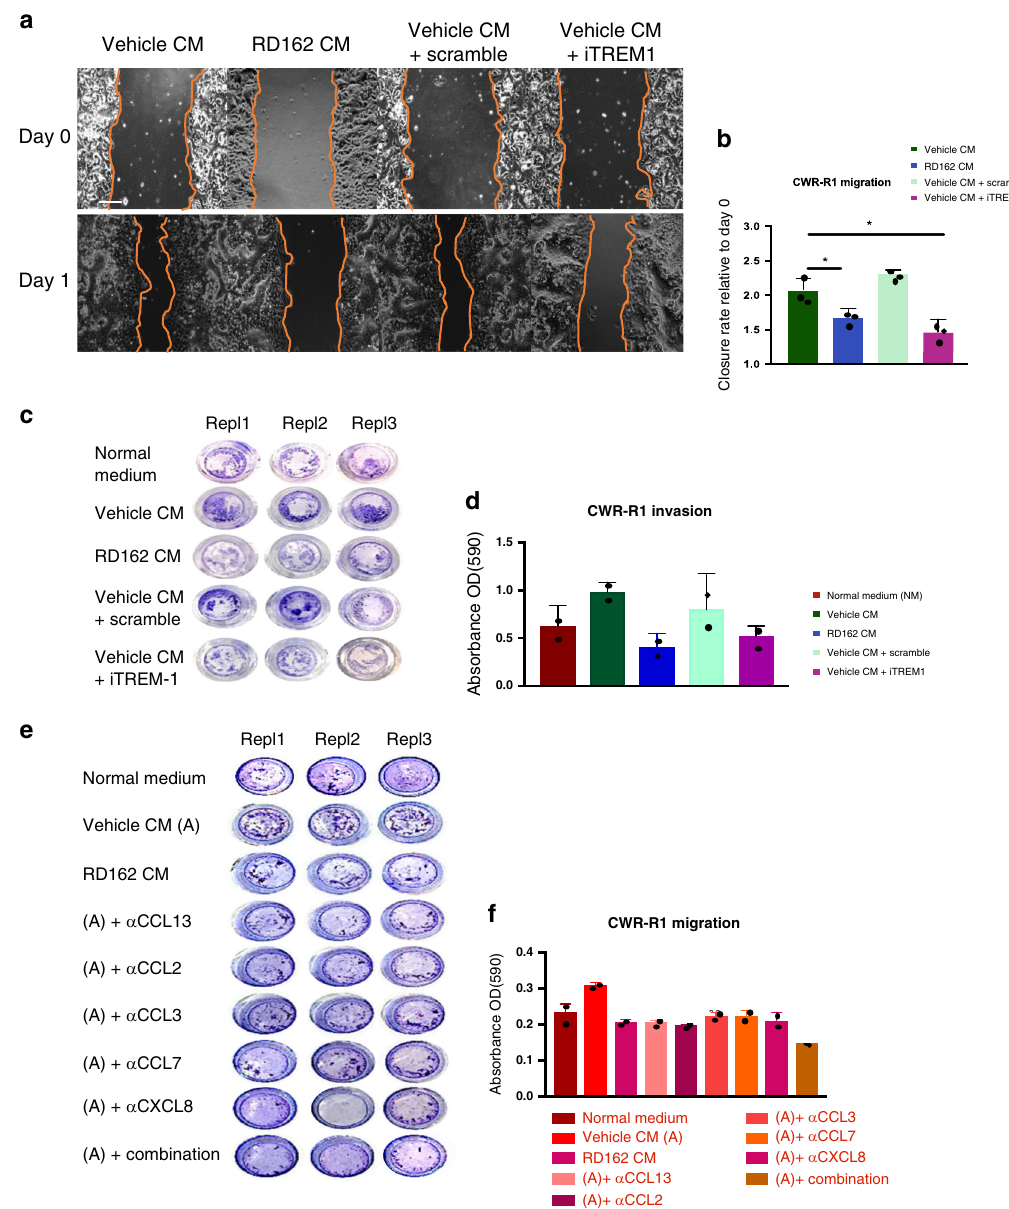
Fig. 7 TREM-1 signalling in THP-1 cells promotes PCa migration and invasion. a Representative images of three independent scratch assays of CWR-R1 cells cultured in CM of THP-1 PMA;IFNG;LPS cells stimulated with vehicle, RD162, scramble peptide or inhibitory TREM-1 peptide (iTREM-1). Three technical replicates were included in each experiment. Scale bar = 200 µ m. b Quanti fi cation of three independent migration scratch assays. Closure of the scratch by CWR-R1 cells after 24 h relative to day 0. Datapoints show mean values of three technical replicates in each experiment. Error bars represent the s.e.m. *: p = 0.05, one-way Anova test was used to calculate the p -value with a cutoff for signi fi cance of 0.05. Source data are provided as a source data fi le. c Representative images of two transwell invasion assays (three technical replicates) of CWR-R1 cells cultured in normal medium alone or in a combination with CM of THP-1 PMA;IFNG;LPS cells stimulated with vehicle, RD162, vehicle CM with scramble peptide or vehicle CM with TREM-1 inhibitory peptide. Cells that invade the matrigel and passed through the membrane after 72 h of culture were stained with crystal violet. d Quanti fi cation of the transwell invasion assays. Invasion was quanti fi ed by optical density (OD) of crystal violet stained cells. Datapoints show mean values and error bars the s.e.m. of two independent experiments with three technical replicates each. Source data are provided as a source data fi le. e Representative images of two transwell migration assays (three technical replicates) of CWR-R1 cells cultured in normal medium alone or in combination with CM of THP-1 PMA;IFNG;LPS cells stimulated with vehicle or RD162. Additionally, CWR-R1 cells cultured in normal medium in combination with CM of vehicle stimulated THP-1 PMA;IFNG;LPS cells alone or supplemented with blocking antibodies against CCL13, CCL2, CCL3, CCL7, CXCL8 or the combination of all. Cells that passed through the membrane after 72 h of culture were stained with crystal violet. f Quanti fi cation of the migration transwell assays. Invasion was quanti fi ed by optical density (OD) of crystal violet stained cells. Datapoints show mean values and error bars the s.e.m. of two independent experiments with three technical replicates each. Source data are provided as a source data fi